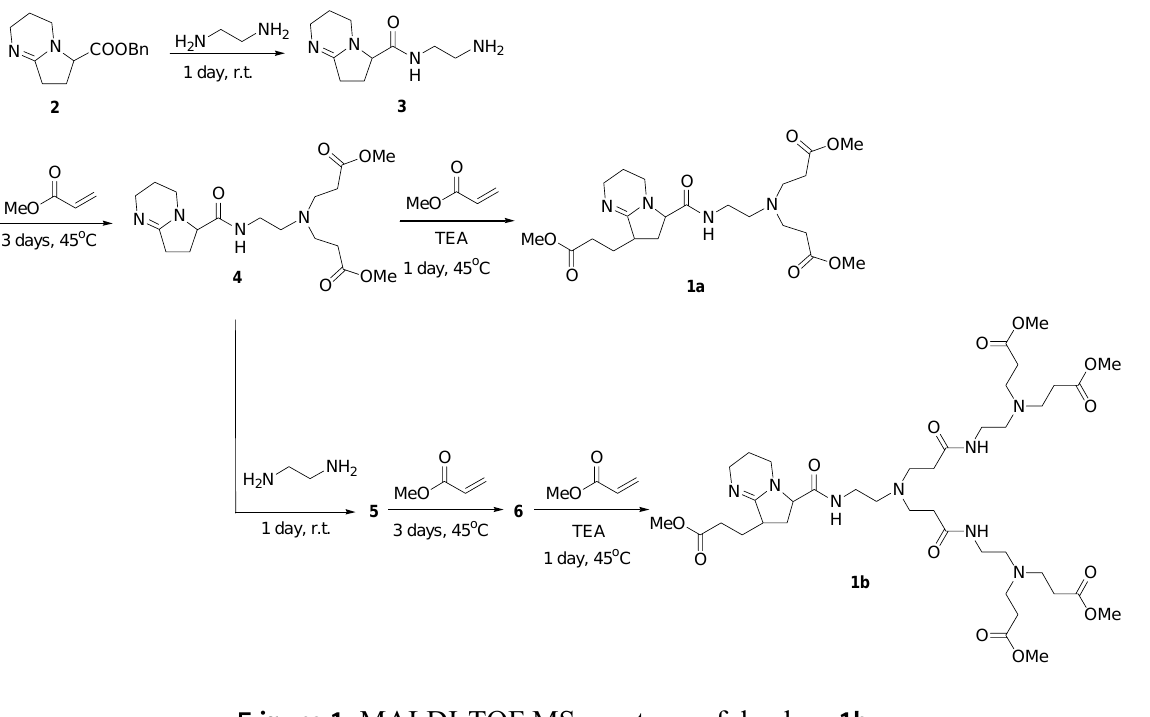
Scheme 1. Syntheses of dendrons 1a and 1b .